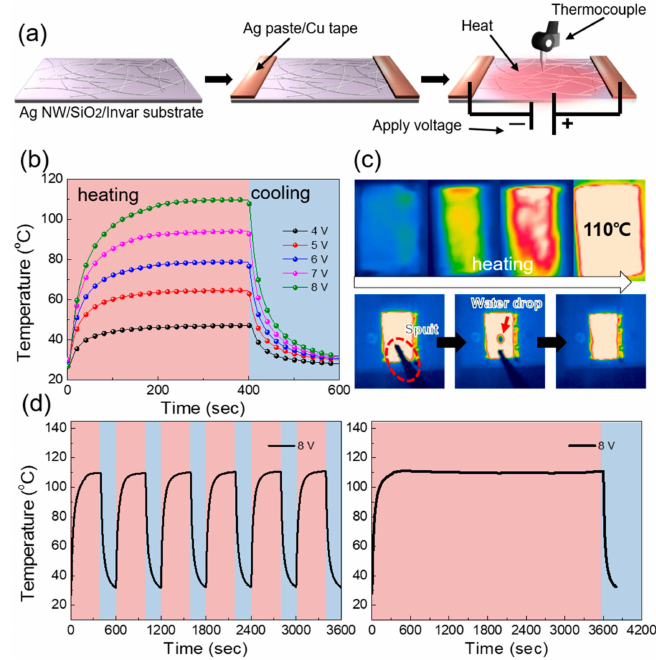
Figure6. PromisingapplicationoftheAgNW / SiO 2 / invarelectrode: Thinfilmheater. ( a )Schematicofthe fabrication of the Ag NW / SiO 2 / invar thin film heater. ( b ) Temperature profile of the Ag NW / SiO 2 / Invar thin film heater with an increase of input voltage. ( c ) IR image of the Ag NWs / SiO 2 / invar electrode and water droplet test on the heated Ag NWs / SiO 2 / invar electrode. ( d ) Thermal stability test of the Ag NWs / SiO 2 / invar